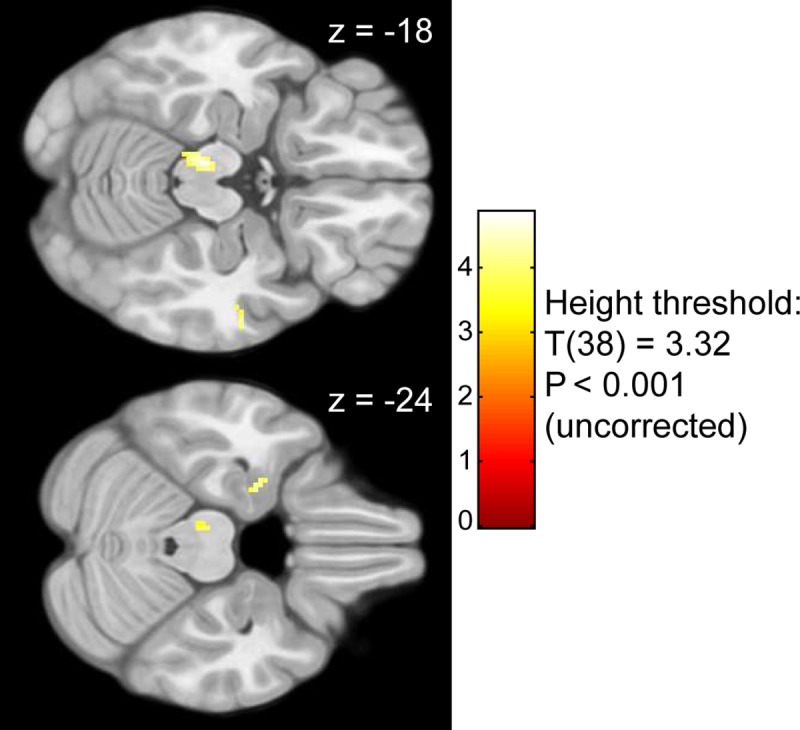
Result for the SPM mass univariate second level contrast [regular products—ONS].The color-coding of the intensity map is based on T value. The transverse slices indicate higher BOLD responses during tasting regular products than tasting ONS products in the amygdala and temporal pole (z = -24), and ventral tegmental area (z = -18).